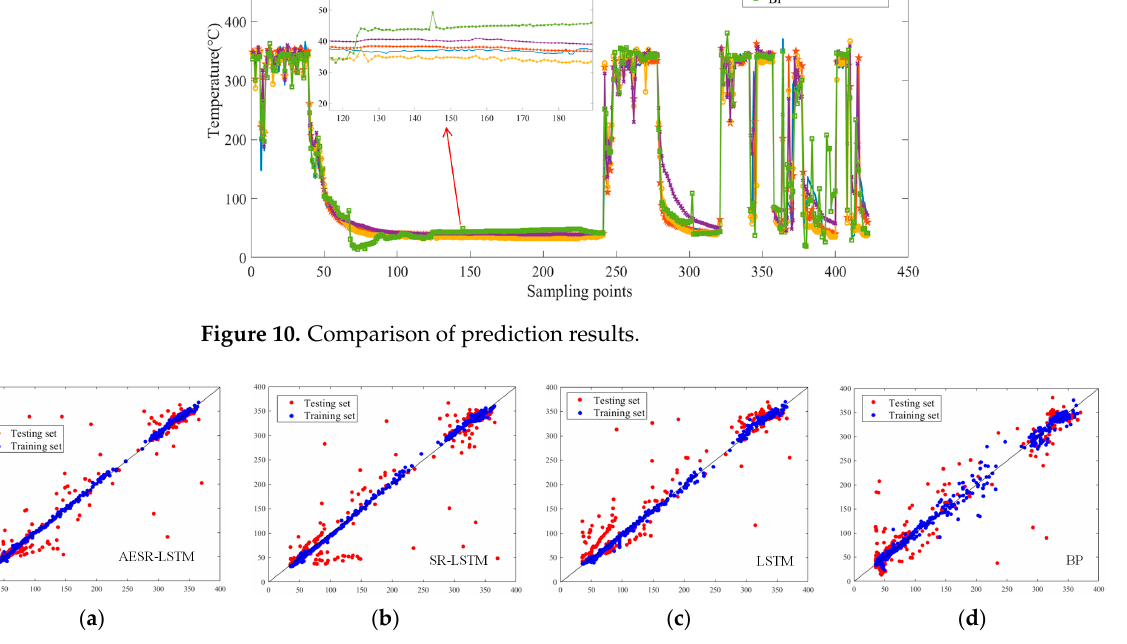
Figure 11. The forecasting and actual temperature for different models: ( a ) Training and test results of AESR-LSTM, ( b ) Training and test results of SR-LSTM, ( c ) Training and test results of LSTM, and ( d ) Training and test results of BP.